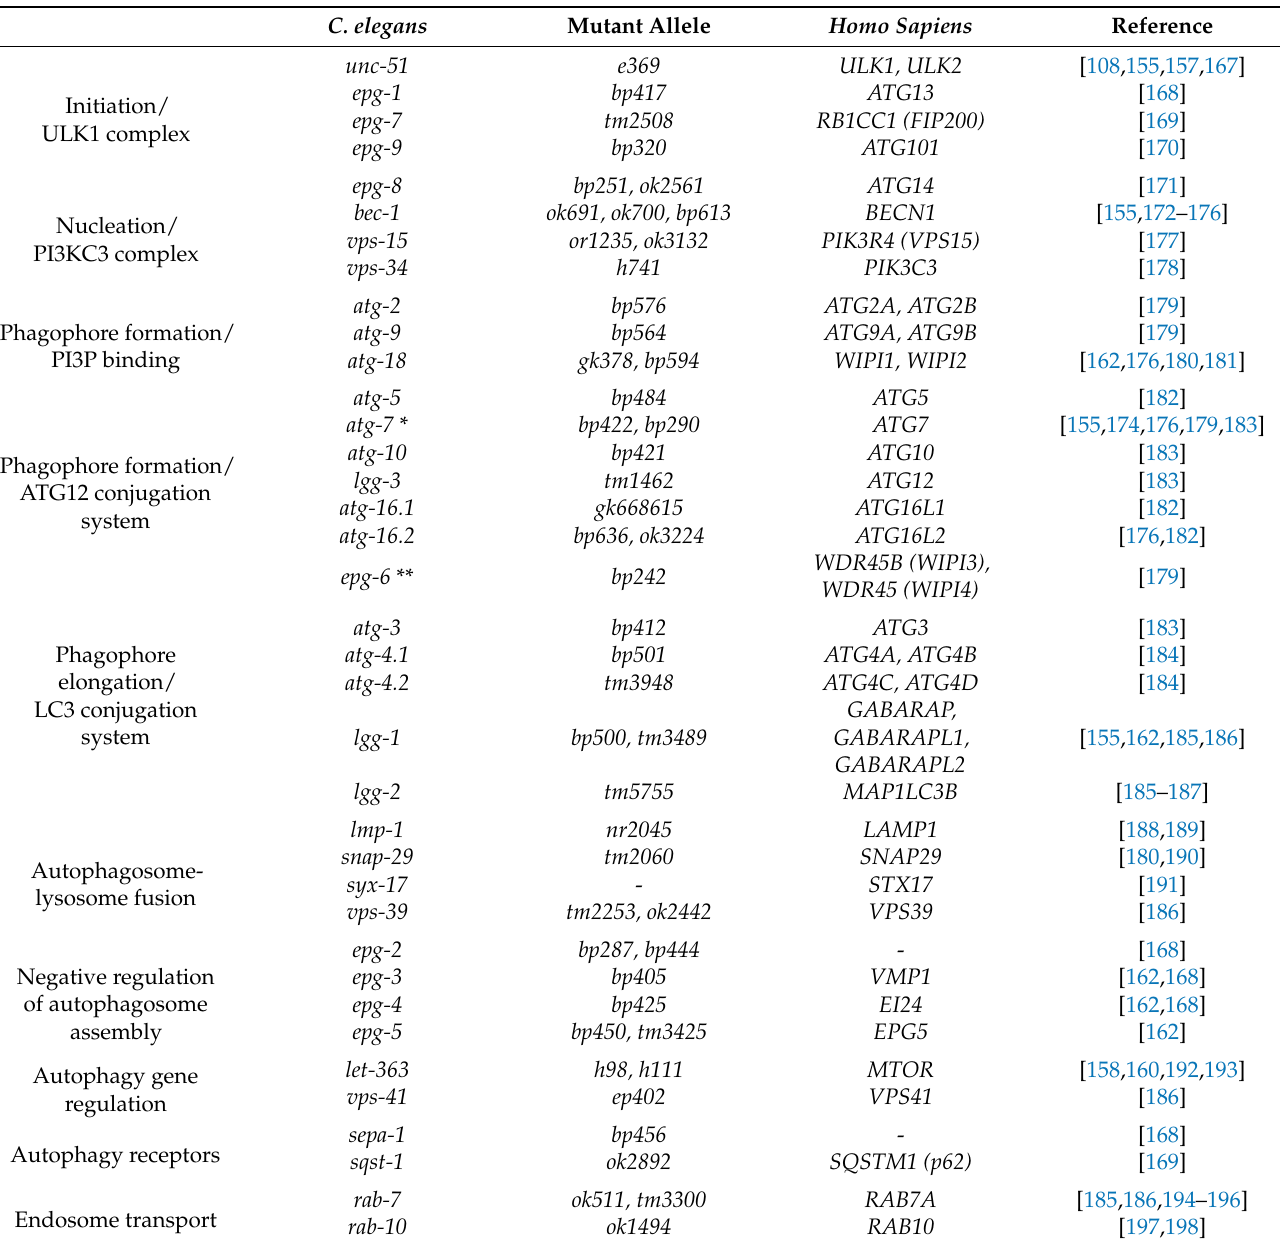
Table 1. Evolutionarily conserved autophagy-related genes of Caenorhabditis elegans .